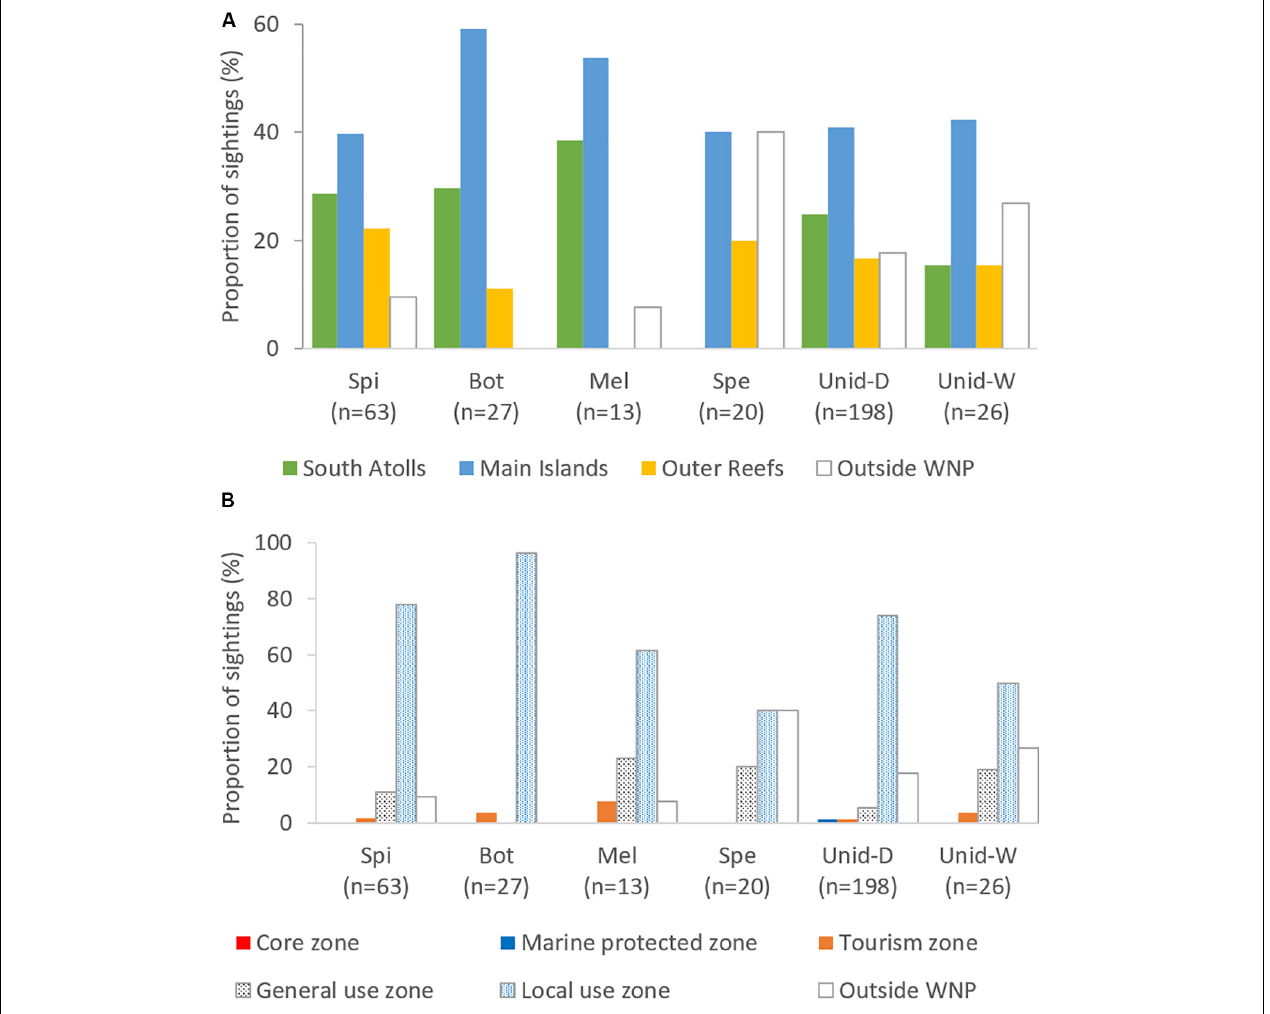
FIGURE 4 | Proportion of sightings based on reef habitat types (A) and WNP zoning system (B) . Bot, Bottlenose dolphin; Spi, Spinner dolphin; Mel, Melon-headed whale; Spe, Sperm whale; Unid-D, Unidentified dolphins; Unid-W, Unidentified